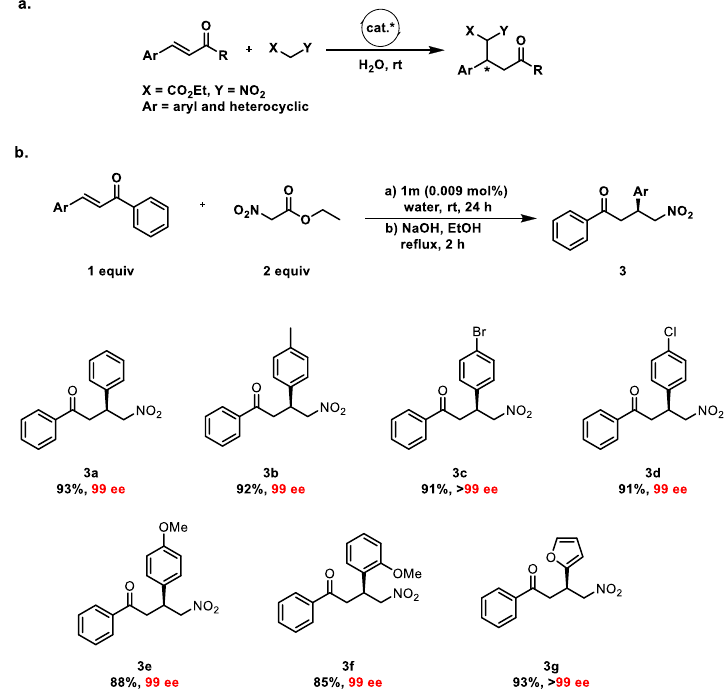
Figure 3. S −form products of the Michael reaction using catalyst 1m. ( a ) Synthesis and reaction scope of the substrate for Michael reaction. ( b ) Trans −chalcone scope of the Michael reaction. The reaction was conducted using trans −chalcone (15 mmol), nitro-ethyl ester (30 mmol), water (30 mL), and catalyst 1m at room temperature.